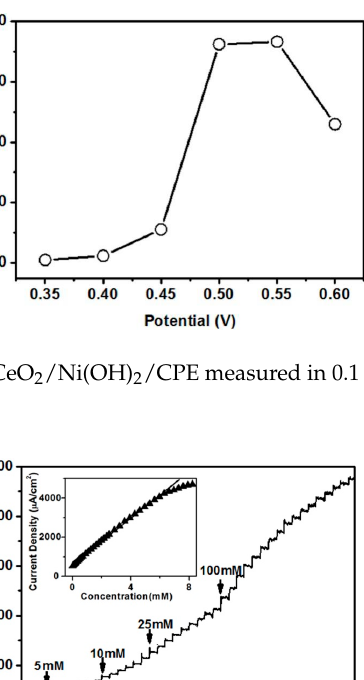
Figure 8. The response current of CeO 2 /Ni(OH) 2 /CPE measured in 0.1 M NaOH for 1 mM glucose at different potentials.